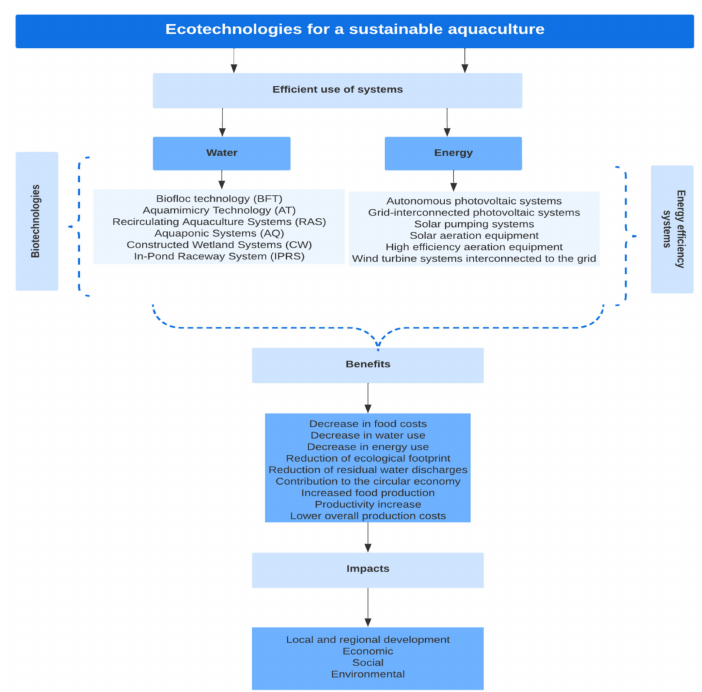
Figure 16. Eco-technologies for sustainable